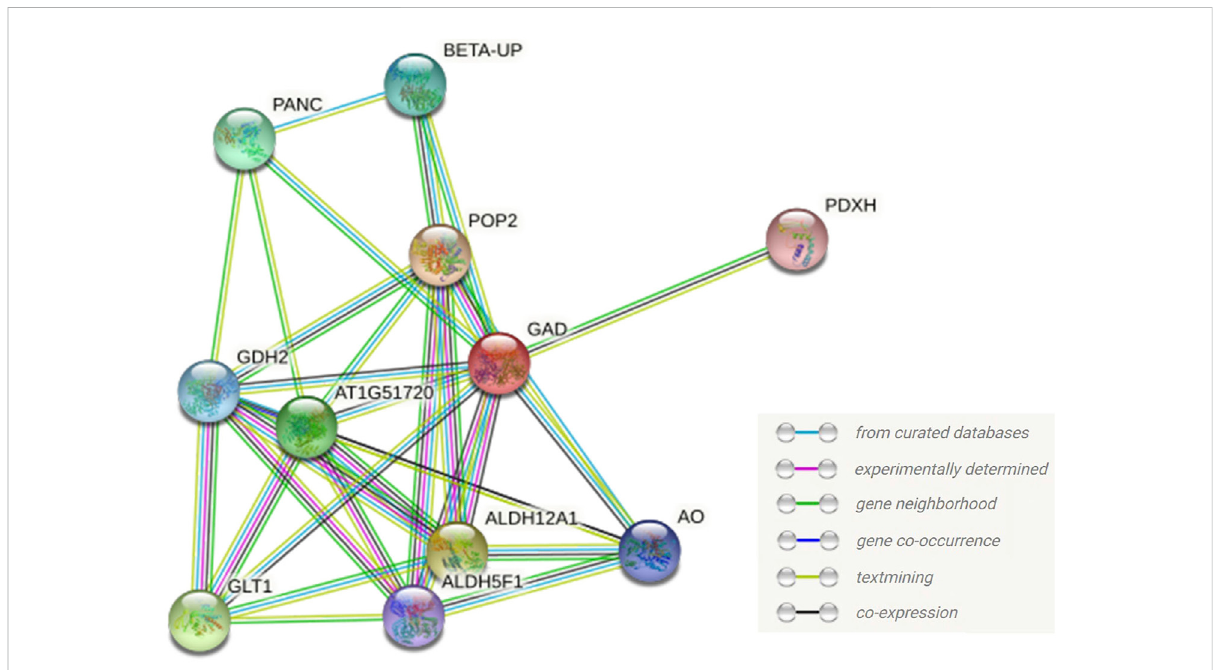
FIGURE 10 Interaction network of GAD protein. The GAD represented the protein AtGAD1 with the highest homology to GhGAD6. All proteins are Arabidopsi s proteins in the